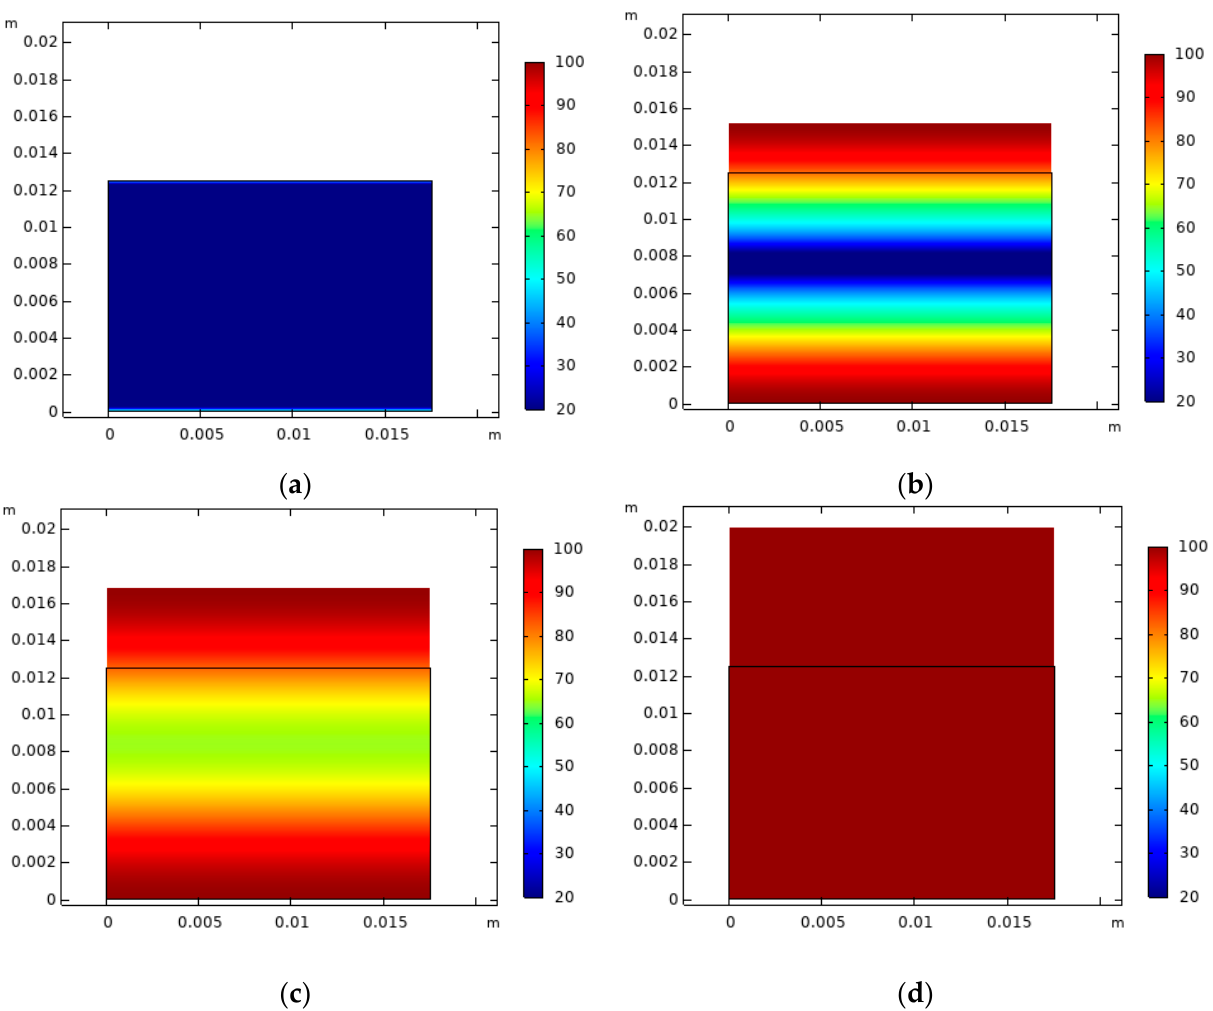
14 of 20 Figure 8. Dry density distribution at different vertical stress (( a ) 𝜎 (cid:3023) = 3.14 MPa, ( b ) 𝜎 (cid:3023) = 7.97 MPa, ( c ) 𝜎 (cid:3023) = 15.97 MPa, ( d ) 𝜎 (cid:3023) = 19.87 MPa) (Path AB’C’, compression stage B’C’). Figure 8 shows the modeling results and demonstrates that dry density would be uniformly distributed (fully homogeneous) within the sample during the compression stage of the experiment. The distribution of dry density (or void ratio) over the sample height has not been reported; thus, the modeling results could not be compared to exper-